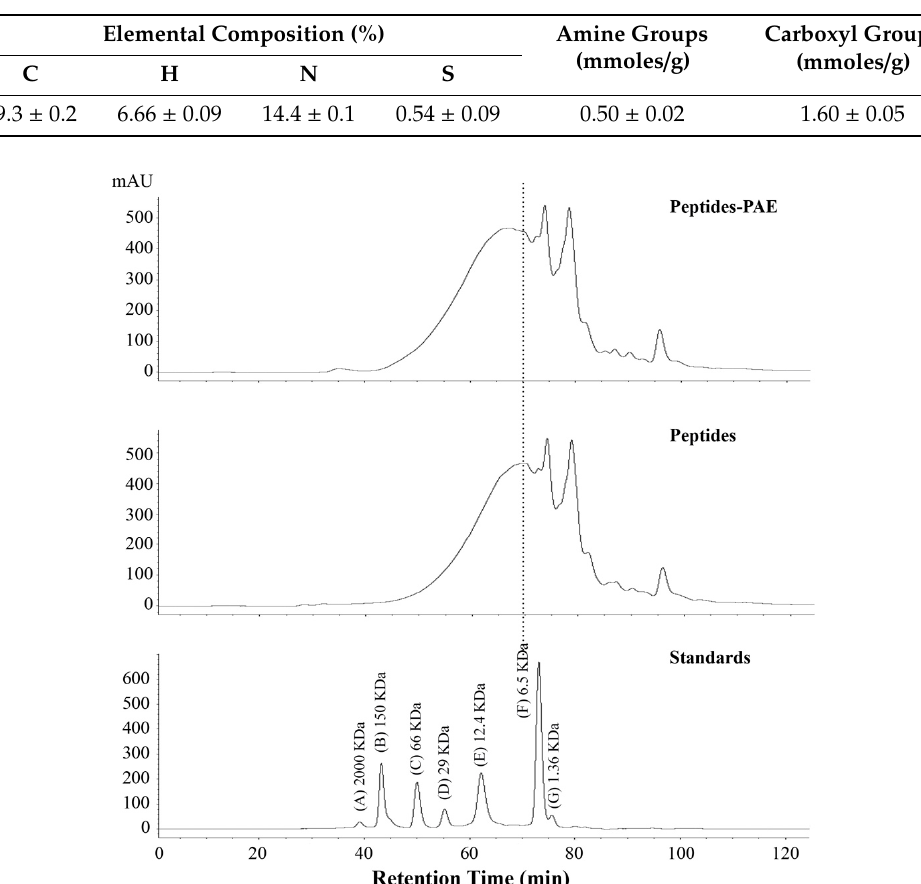
Table 1. Elemental composition and functional group analysis of peptides recovered from hydrolyzed Specified Risk Materials (SRM).